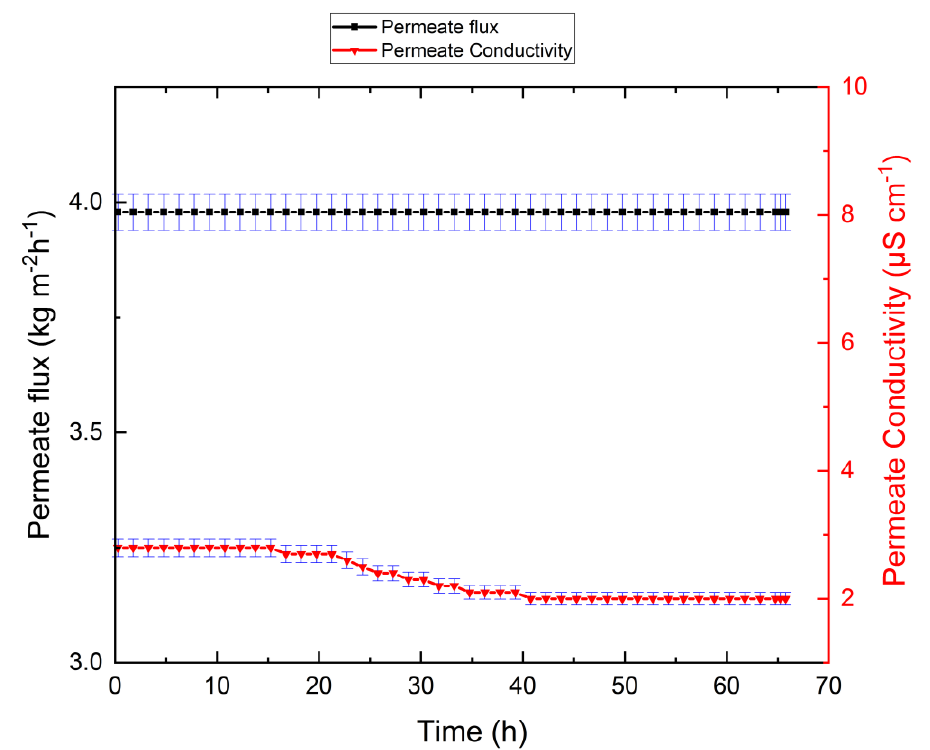
Figure 2. Linz tap water VMD test showing permeate flux and permeate electrical conductivity against time. The system exhibited no reduction in permeate flux during the experiment.